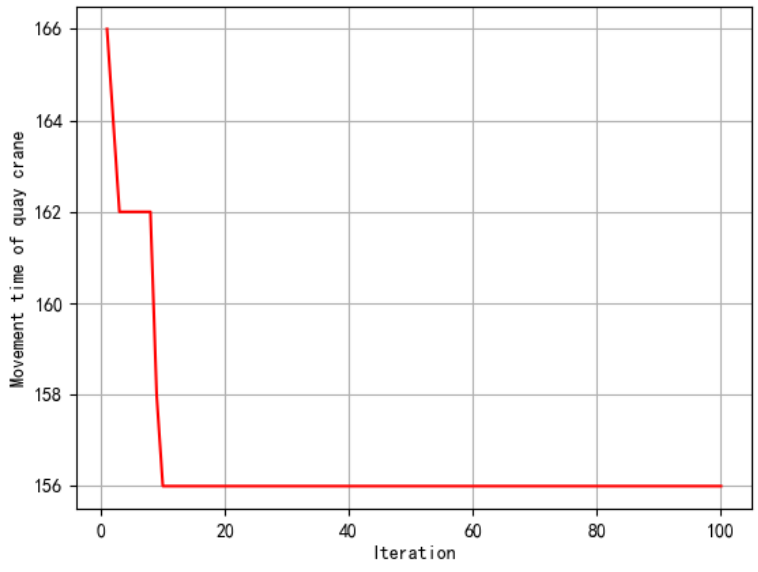
Figure 13. The convergence graph of double-bay.